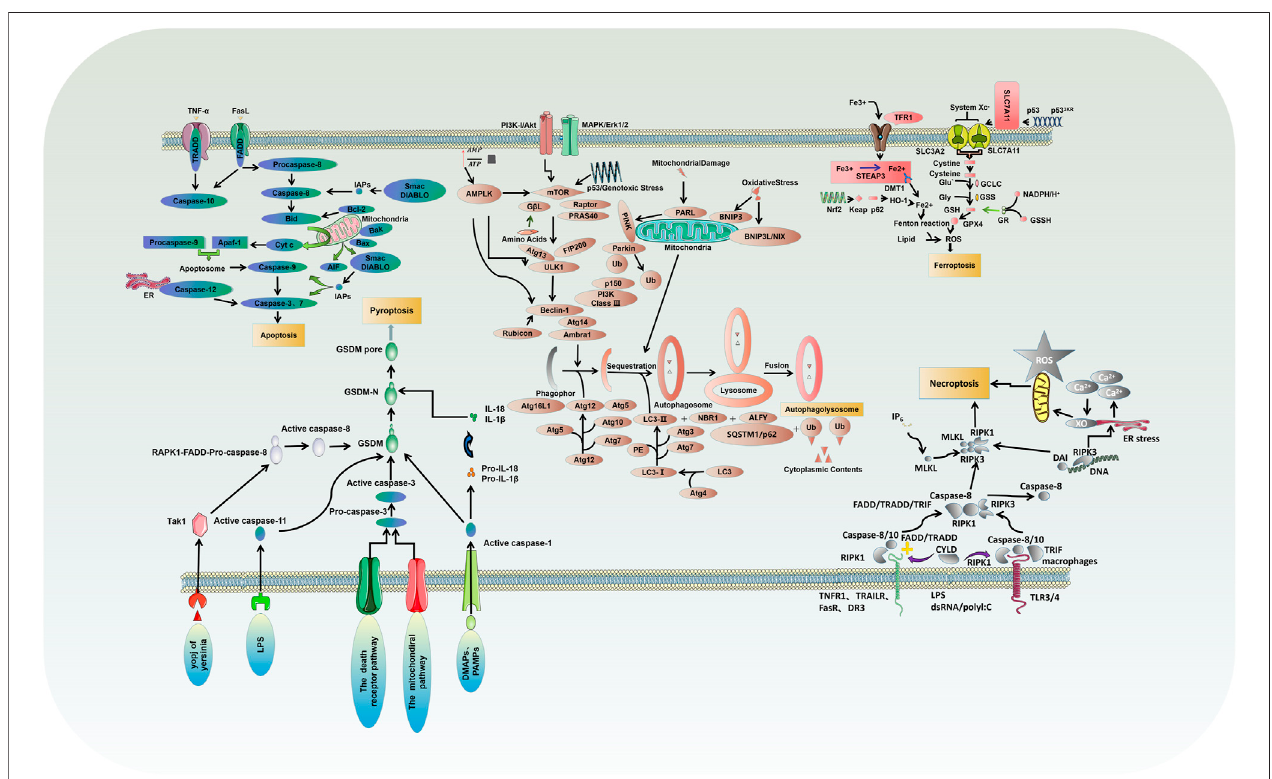
FIGURE 1 | Molecular mechanisms of different types of PCD: critical molecular pathways of autophagy, apoptosis, necrosis, pyroptosis and ferroptosis.